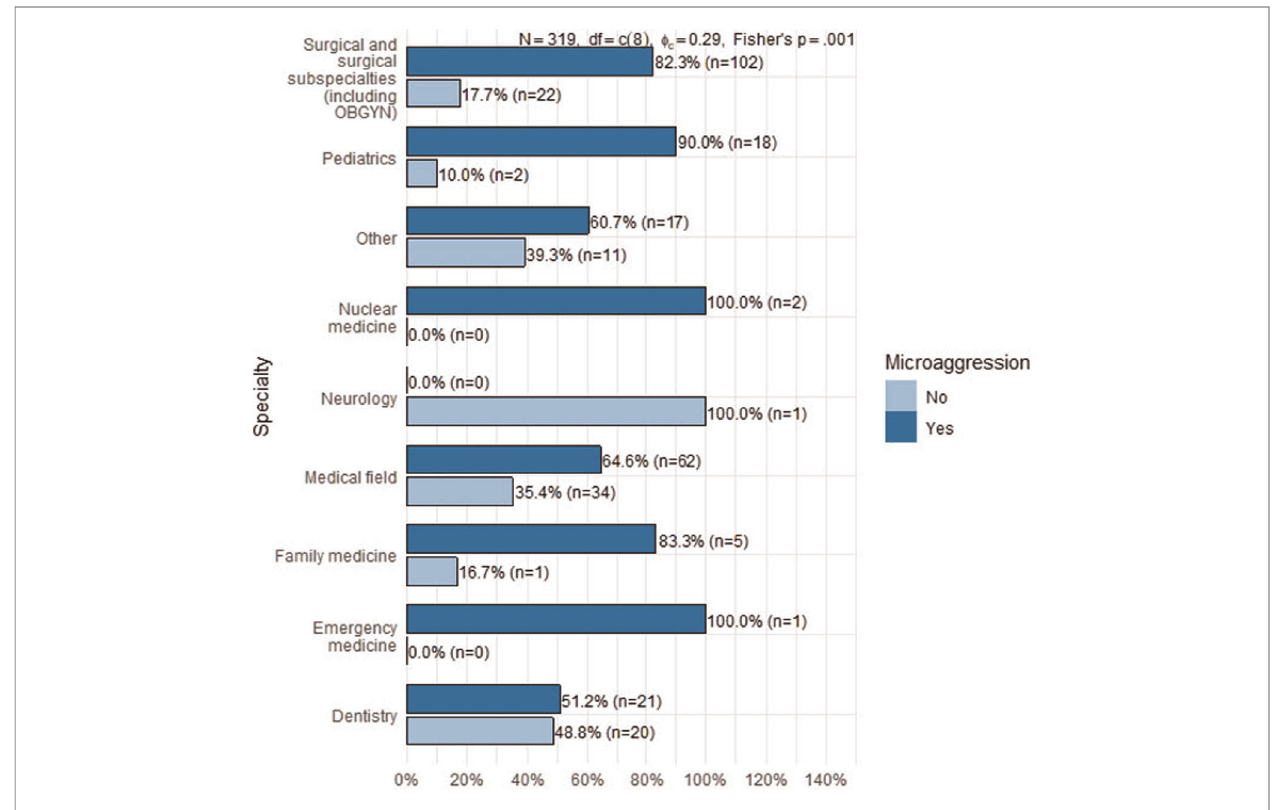
FIGURE 1 | Exposure to microaggressions by specialty.